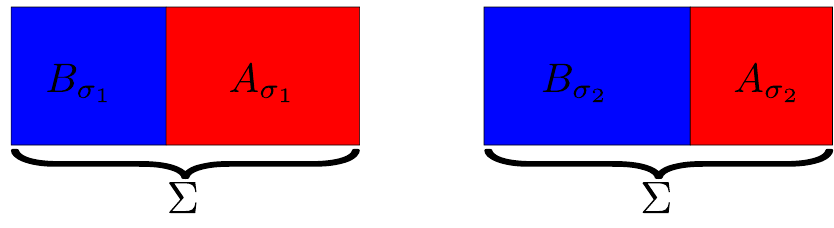
Figure 1 . The families of entangling regions A (cid:27) and B (cid:27) . We consider two families of entangling regions A (cid:27) (red) and B (cid:27) (blue) with A (cid:27) (cid:26) A (cid:27) for (cid:27) 1 < (cid:27) 2 and A (cid:27) B (cid:27) = (cid:6) = const: In particular, 2 1 this implies B (cid:27) (cid:26) B (cid:27) 1 2